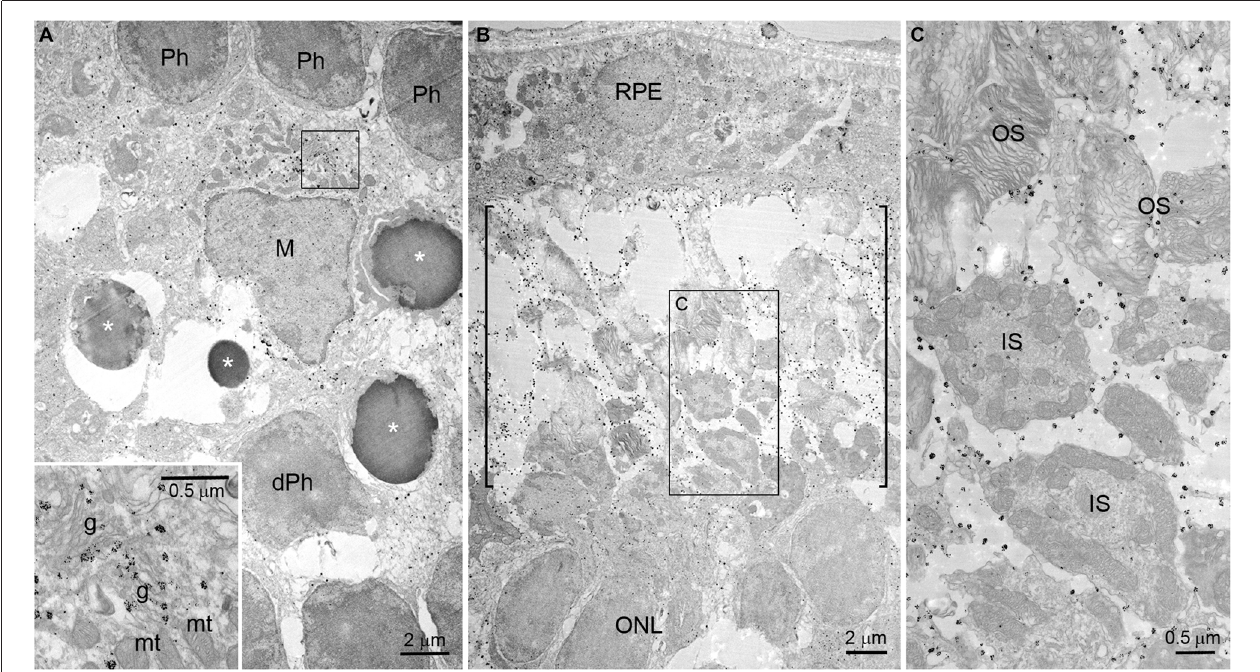
FIGURE 5 | Immunogold electron microscopy of OPN in blue LED-induced RD retinas. Electron micrographs taken from vertical sections of an RD retina at 72 h after blue LED exposure that was processed for OPN immunoreactivity. (A) OPN localization in the ONL. OPN labeled with immunogold was observed in the cytoplasm of microglia (M) in the ONL. Photoreceptors (Ph) ongoing apoptosis (asterisks) or with degenerative changes (dPh) were frequently observed nearby. A portion of microglial cytoplasm (rectangle) is magnified in the inset . In the inset , immunogold is observed associated with vesicular structures proximal to Golgi complexes (g) but not with mitochondria (mt). (B,C) OPN localization in the subretinal space. Large numbers of immunogold particles were present in subretinal space (bracket). In a higher magnification view (C) of the rectangular region (B) , immunogold is observed associated with the membranes of fragmented or degenerating outer segments (OS) packed with membranous discs, and inner segments (IS) containing numerous mitochondria. RPE, retinal pigment